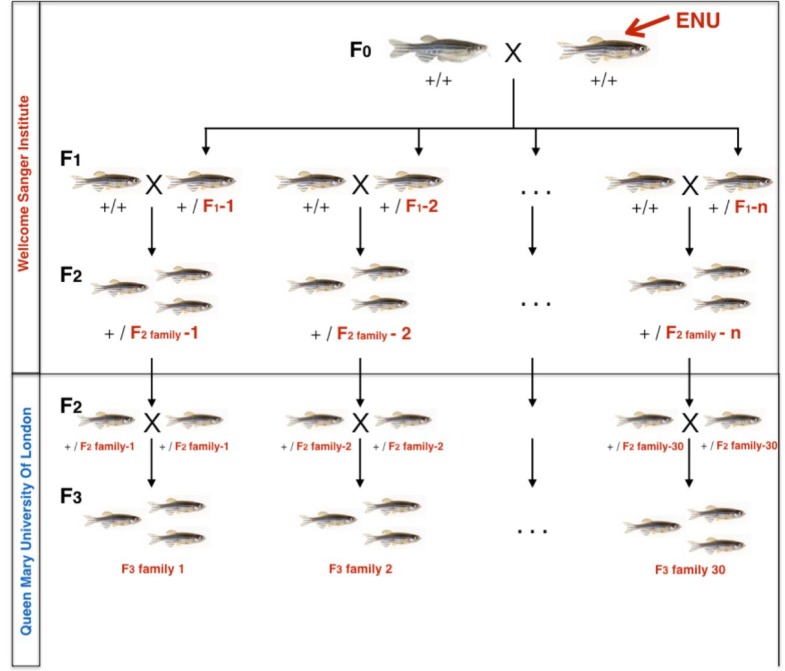
Zebrafish breeding scheme to generate F3 families.F2 ENU-mutagenized zebrafish, heterozygous for multiple mutations across the entire genome were obtained from the Wellcome Sanger Institute as part of the Zebrafish Mutation Project. At QMUL, heterozygous F2 fish were incrossed to generate 30 F3 families, each containing 10–20 nonsense or essential splice site mutations and about 1500 additional exonic and intronic point mutations. F3 Families were arbitrarily numbered 1–30. Expected mutation rate and type of mutations in coding regions are specified on the right hand side.